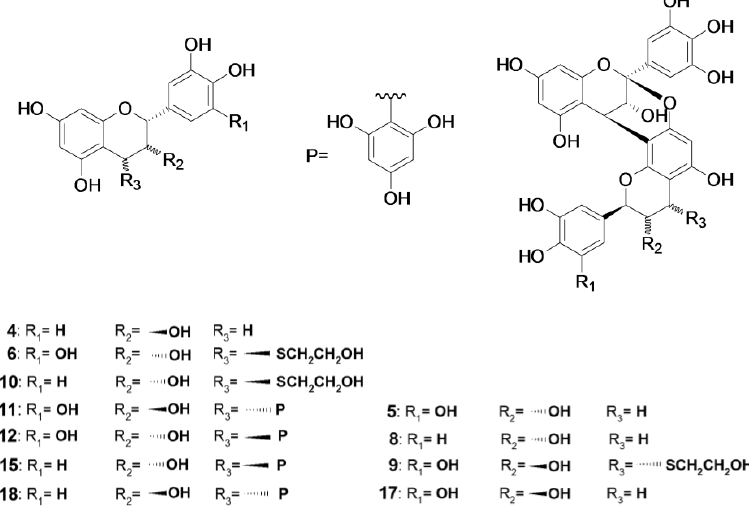
Figure 4. Structures of known degradation products.